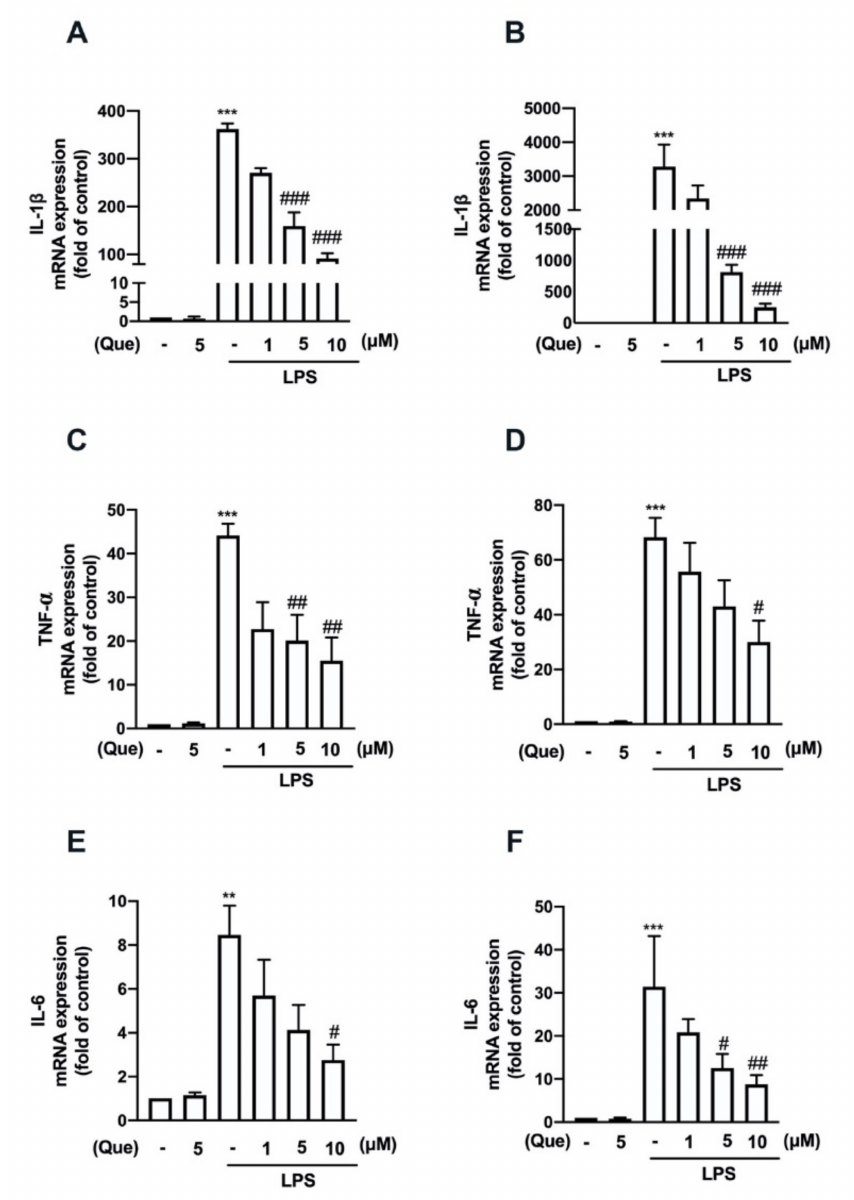
Figure 4. Inhibitory effects of quercetin on the expression of proinflammatory mediators in macrophages and microglial cells. RAW264.7 ( A , C , E ) and IMG ( B , D , F ) cells were stimulated with various concentrations of quercetin (1, 5, or 10 µ M) for 30 min followed by stimulation with LPS (50 ng/mL) for another 6 h. mRNA levels of interleukin (IL)-1 β ( A , B ), tumor necrosis factor (TNF)- α ( C , D ), and IL-6 ( E , F ) were analyzed by real-time PCR and normalized to β -actin. Each bar represents the mean ± SEM of n = 3–4. *** p < 0.005, ** p < 0.01 compared with the control group. Note: ### p < 0.005, ## p < 0.01, # p < 0.05 compared with the LPS alone